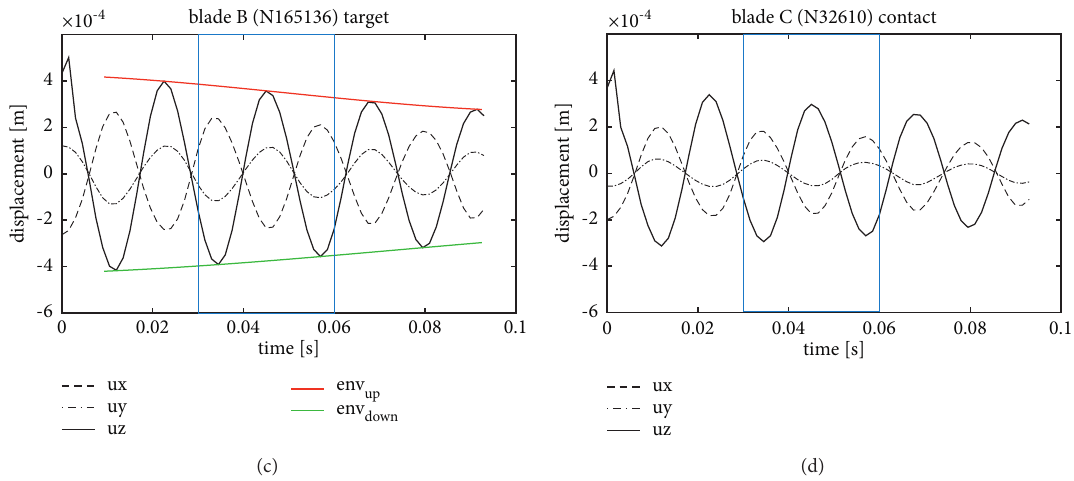
Figure 13: Time characteristics of displacements of blades BA, BB, and BC in nodes of target-contact pairs: (a)-(b) contact (A); (c)-(d) contact (B). Amplitude envelopes are denoted by red and green lines—2 ND mode.